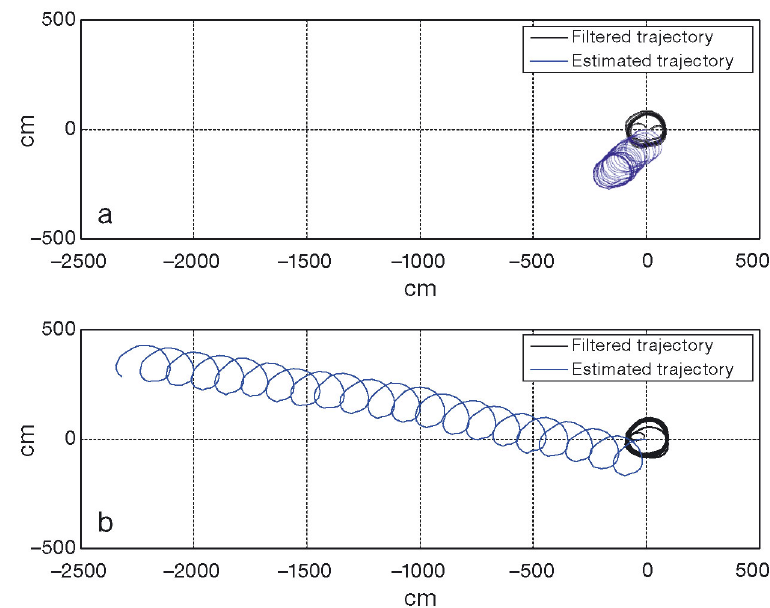
Fig. 6. Results of the flume tank experiment. (a) Water stop, (b) steady flow (10 cm s –1 ). Black lines = reconstructed trajectories; blue lines = corrected trajectories from which accumulated error had been removed using the high-pass filter